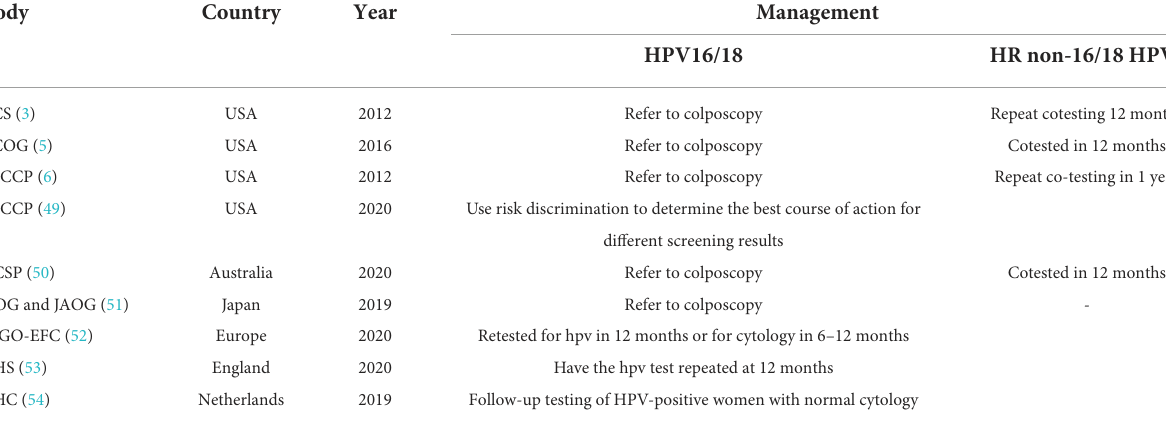
TABLE 4 Summary of the current major guidelines in the management of negative for intraepithelial lesion or malignancy (NILM) women positive for non-16/18